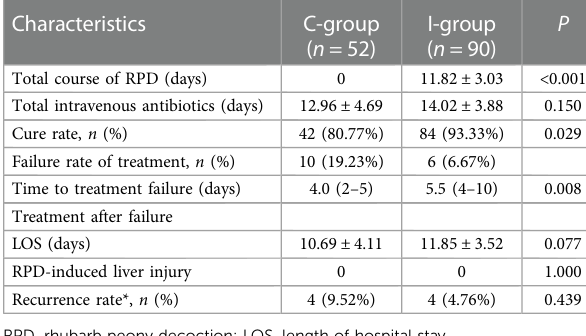
RPD, rhubarb peony decoction; LOS, length of hospital stay. a Patients with treatment failure were excluded; cure rate=(number of people cured/total number)×100%.